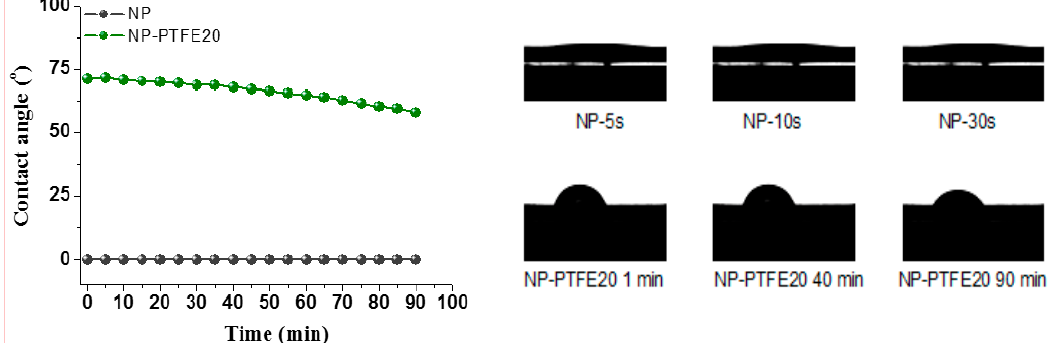
Figure 15. Contact angle between oil and paperboard.